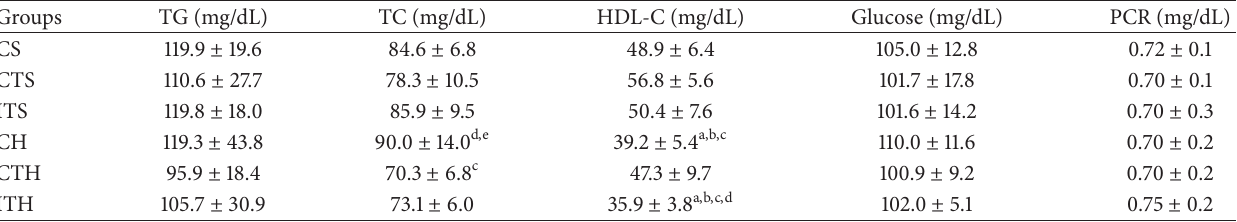
Table 4: Serum lipid profile, glucose, and C-reactive